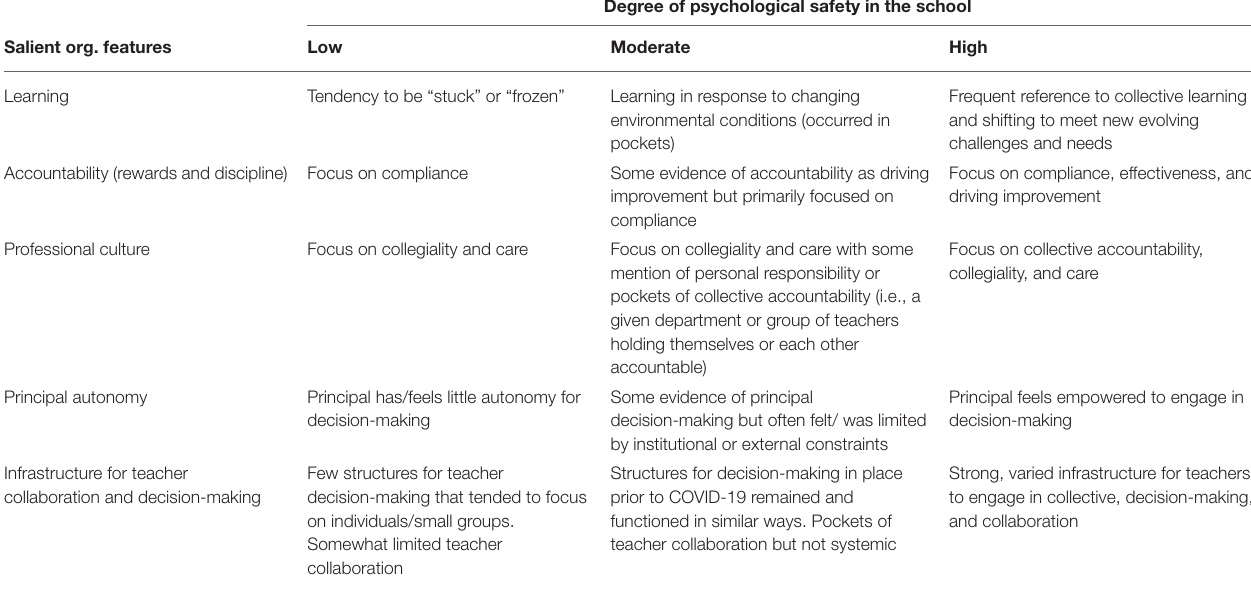
Degree of psychological safety in the school